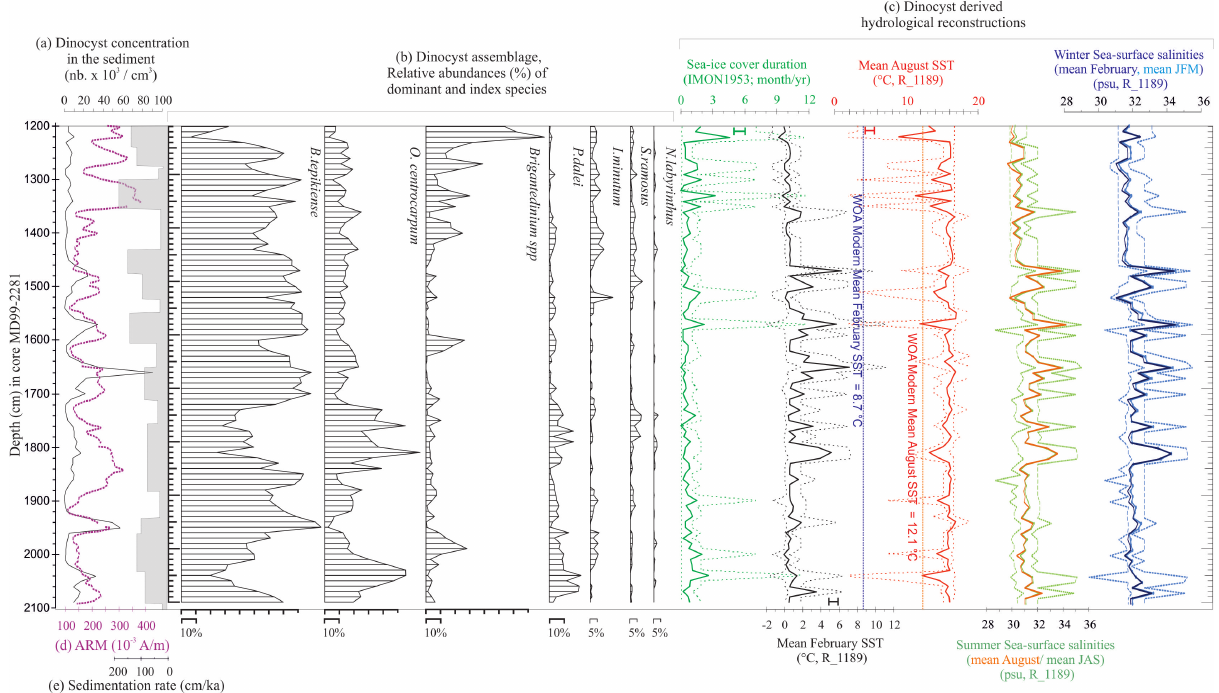
Fig. 5. Results from dinocyst analyses (see also Table 2) over the section 1200–2100cm in core MD99-2881, with (a) dinocyst total concen- trations in the sediment (nb. of cyst/cm 3 of dry sed.); (b) relative abundances of some selected species; (c) Dinocyst derived reconstructions (modern analogue technique) of sea-surface conditions (sea-ice cover duration ± 1.1 months per year; February SST ± 1.1 ◦ C; August SST ± 1.6 ◦ C; February SSS ± 2.2; August SSS ± 2.5; mean winter SSS ± 2.3; mean summer ± 2.4psu). The dotted lines surrounding each reconstructed parameter correspond to minima and maxima values found in the set of the 5 selected analogues. Modern values of SSTs after WOA (1998). These results are compared to (d) the ARM (for anhysteretic remanent magnetization) data and (e) the sedimentation rate calculated from our age model (see Fig.